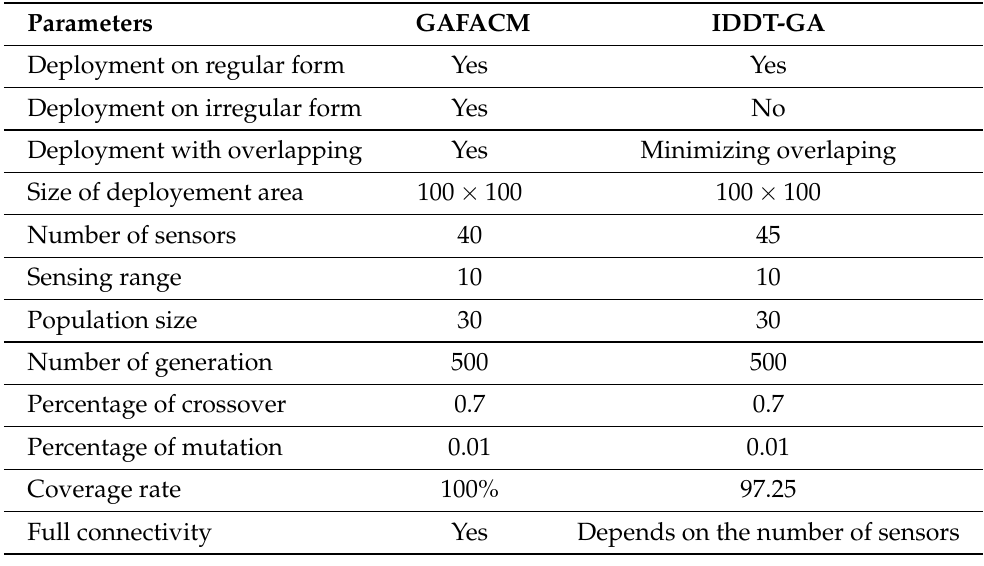
Table 4. Comparison parameters.